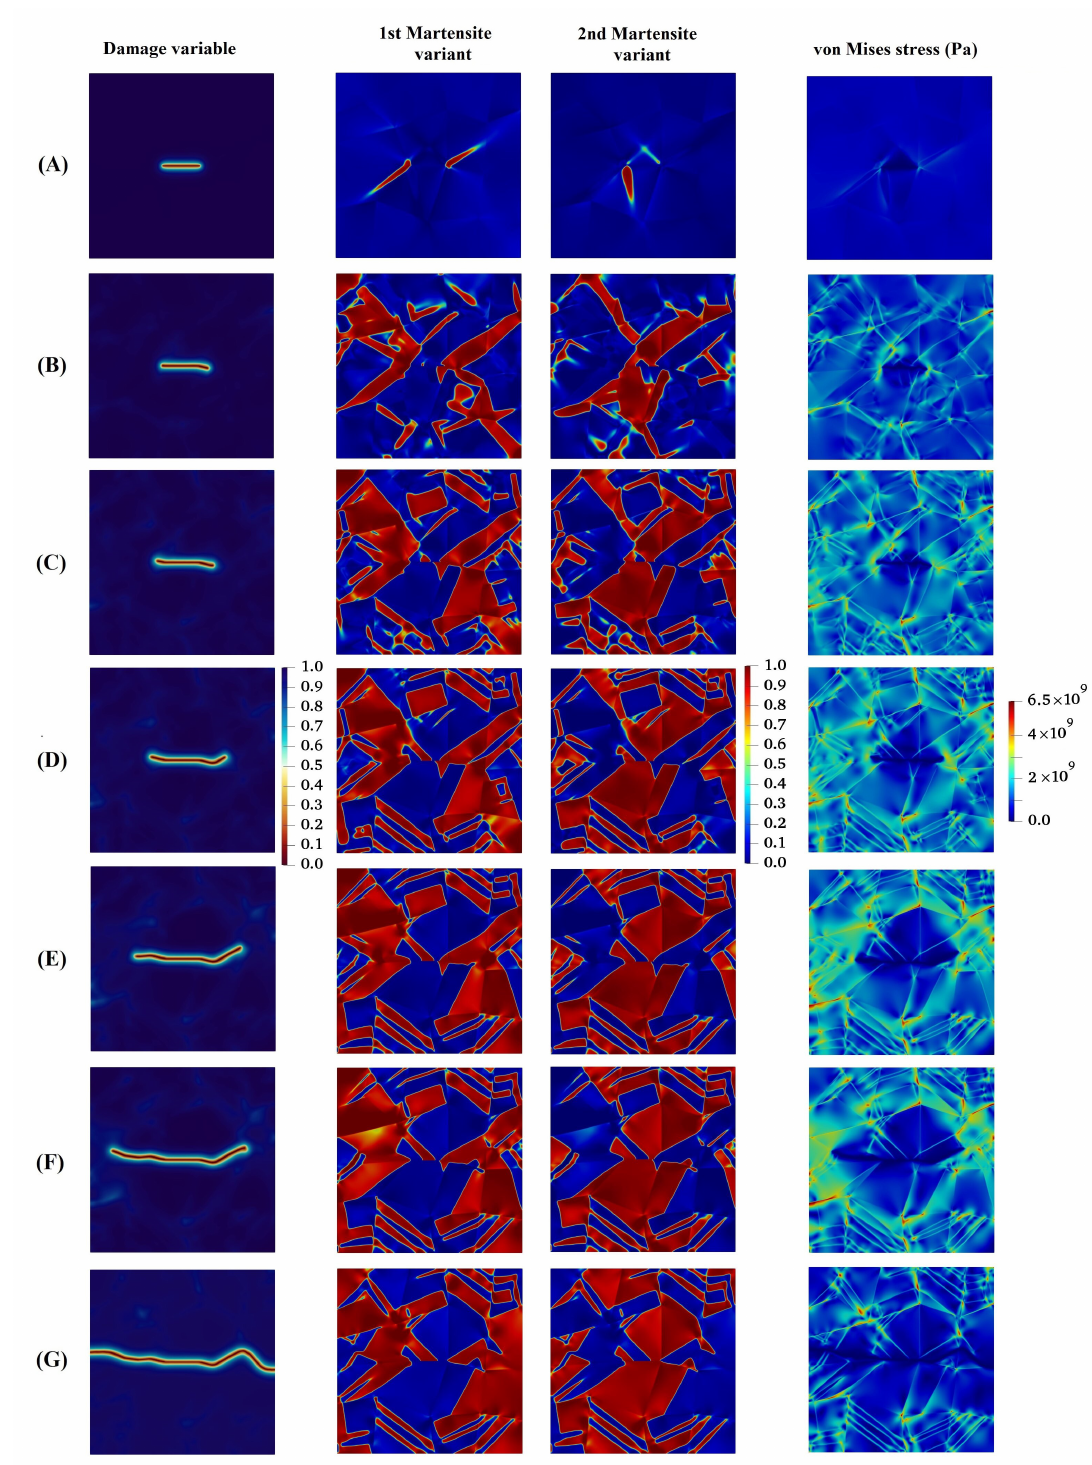
Figure 15. Evolution of damage variable, two martensite variants, and von Mises stress in the polycrystalline